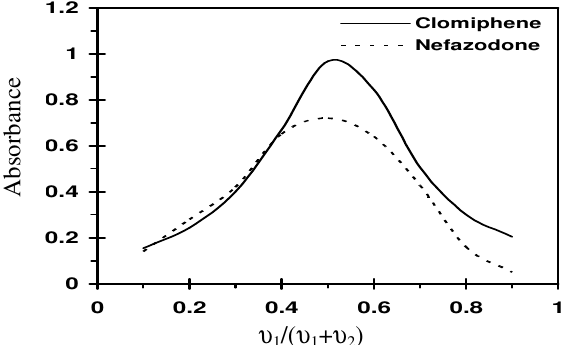
Figure 4. Continuous variation plot for 0.01M clomiphene citrate or nefazodone HCl and 0.01 M ammonium